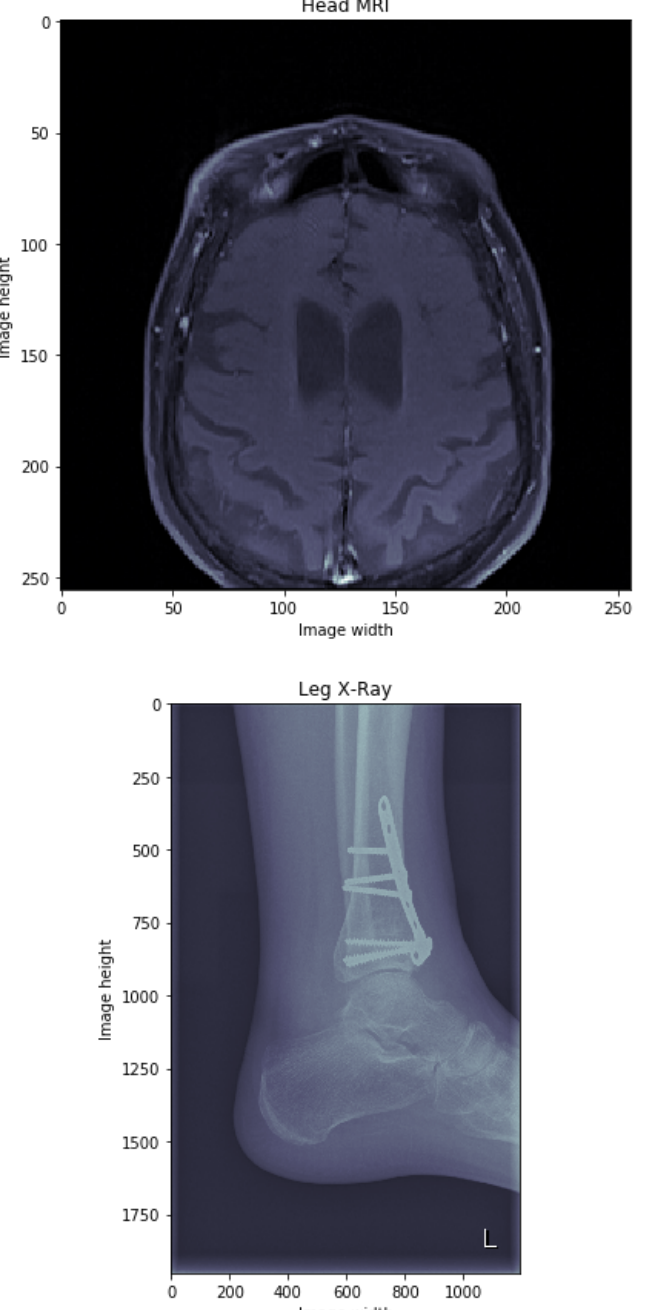
Figure 2. Example medical images. Original dimensions, expressed using the number of pixels, are indicated on each